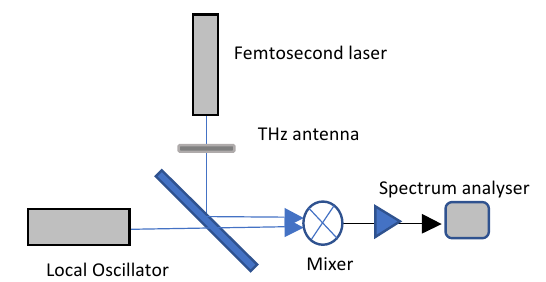
Fig. 2. Heterodyne spectrometer. The THz FC is produced by focusing optical fs pulses onto a a photoconductive di- pole antenna. The THz FC and the local oscillator (formed by an amplifier multiplier chain driven by a synthesizer) is overlapped by a beam splitter to feed a subharmonic mixer. After amplification, the intermediate frequency (IF) signal is recorded by a classical spectrum analyzer.